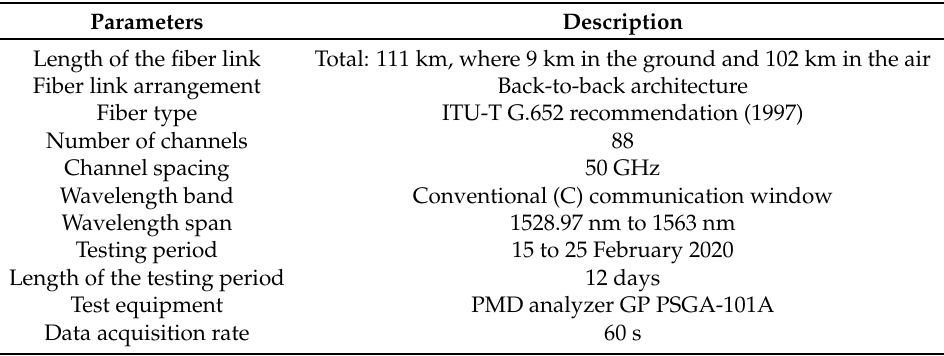
Table 1. Summary of parameters in use for experimental